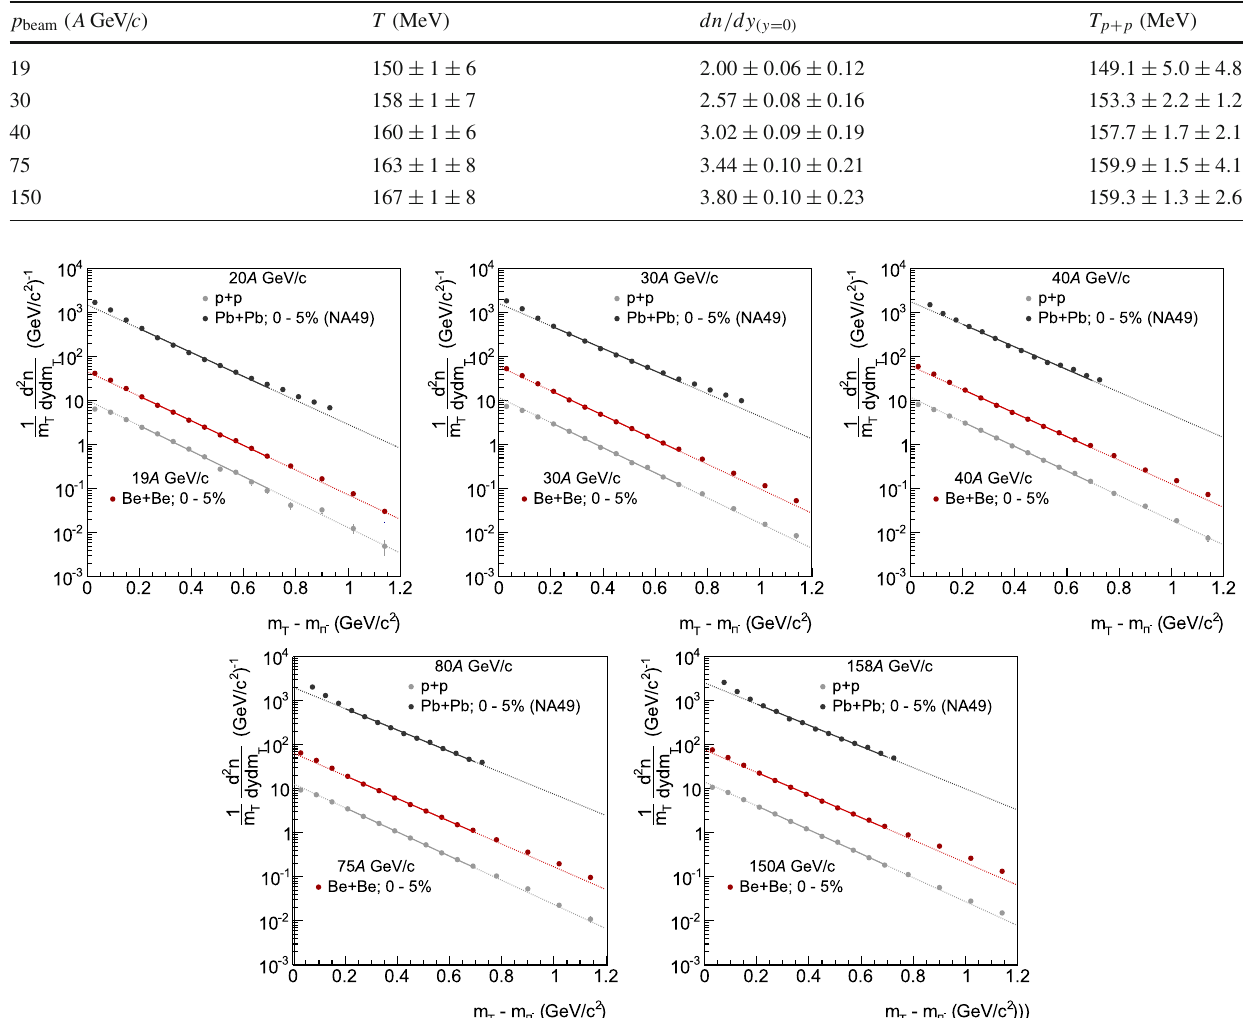
d 2 n Fig. 13 Transverse mass spectra 1 of negatively charged tical errors are smaller than the size of the points. Results from inelastic m T dydm T p+p interactions [12] and central Pb + Pb interactions [2,3] are shown pions produced in central Be + Be collisions at the SPS energies. Statis- for comparison. Lines show exponential fits with Eq.